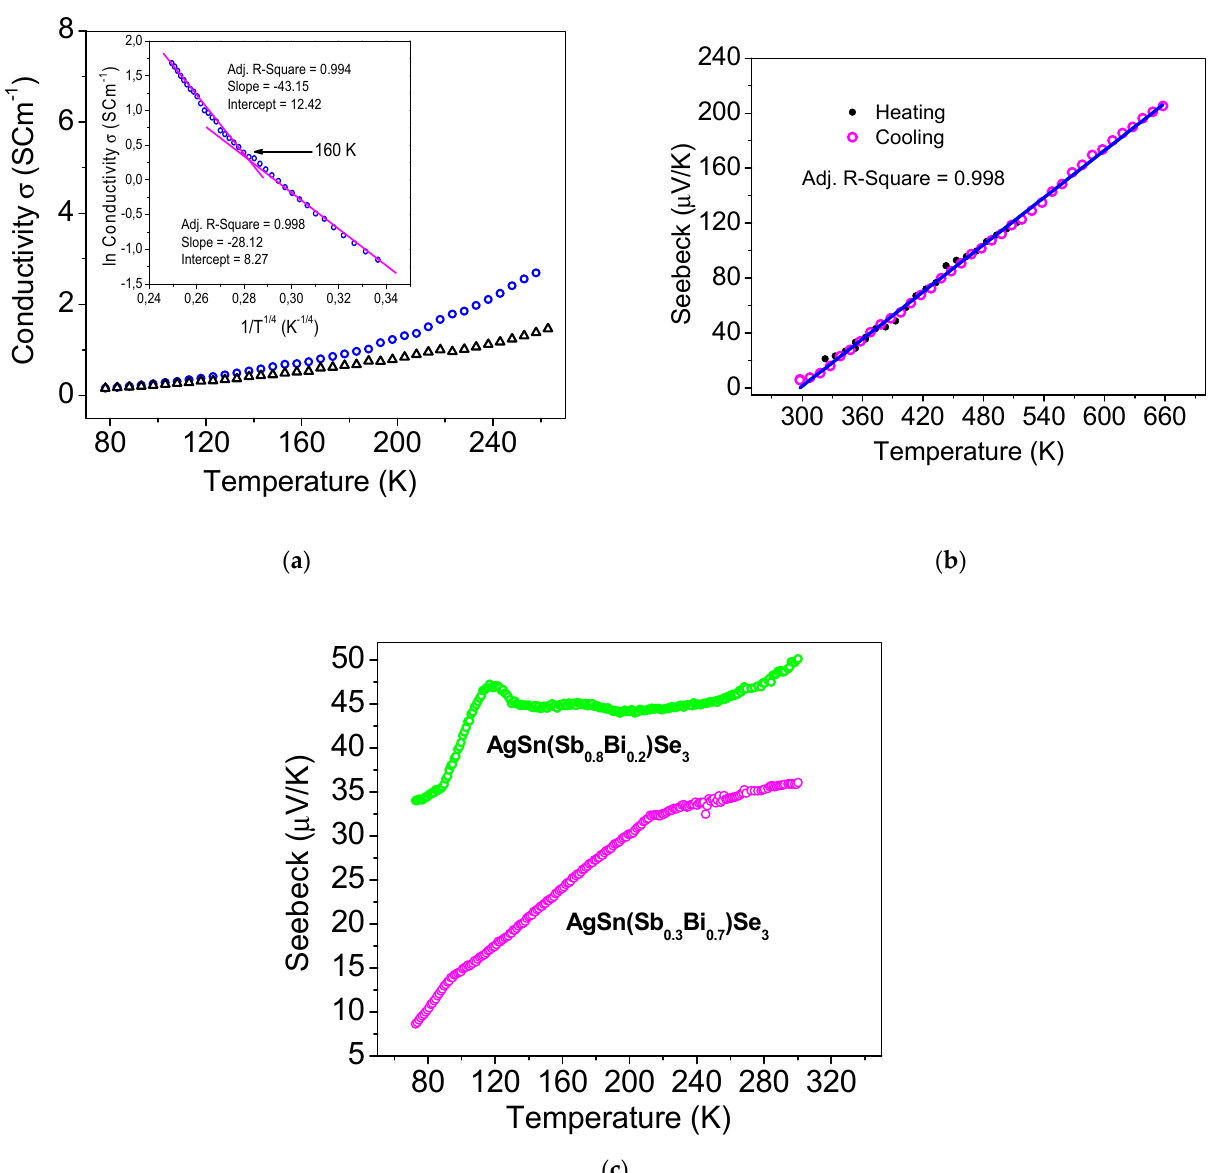
Figure 5. Temperature dependences of the electrical conductivity and Seebeck coefficient determined for AgSn[Bi 1 − x Sb x ]Se 3 . ( a ) Electrical conductivity–temperature plots of AgSnBiSe 3 sintered at 673 K in Ar 12 h (open triangles) and AgSnBiSe 3 sintered at 923 K in Ar for 48 h (open circles). The inset shows the ln σ vs. T − 1/4 curve, and the solid lines denote the linear fit of the experimental data. ( b ) Plots of Seebeck coefficient vs. temperature (heating–cooling cycle measurements) obtained for AgSnBiSe 3 . ( c ) Plots of Seebeck coefficient vs. temperature obtained for AgSn[Bi 1 − x Sb x ]Se 3 ( x = 0.8 and 0.3) in the low-temperature range.